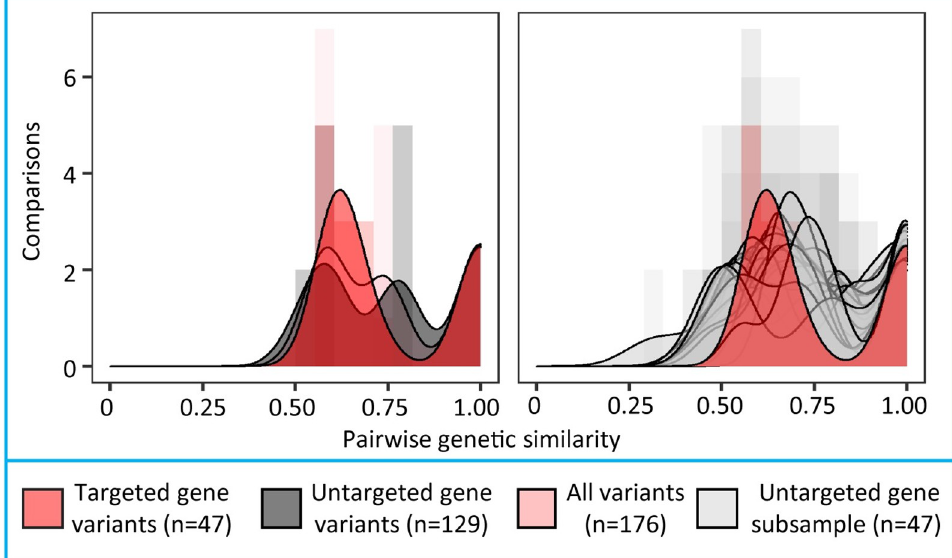
Fig 4. Distribution of all-by-all pairwise genetic similarity of variants within or outside of amplification targeted genes. Targeted gene variant regions were determined with CO3, cytB, and ND3–5 genomic ranges specified in the mitochondrial reference genome. Smoothed density kernel distributions are overlayed on pairwise genetic similarity distribution histograms for the different genomic regions.